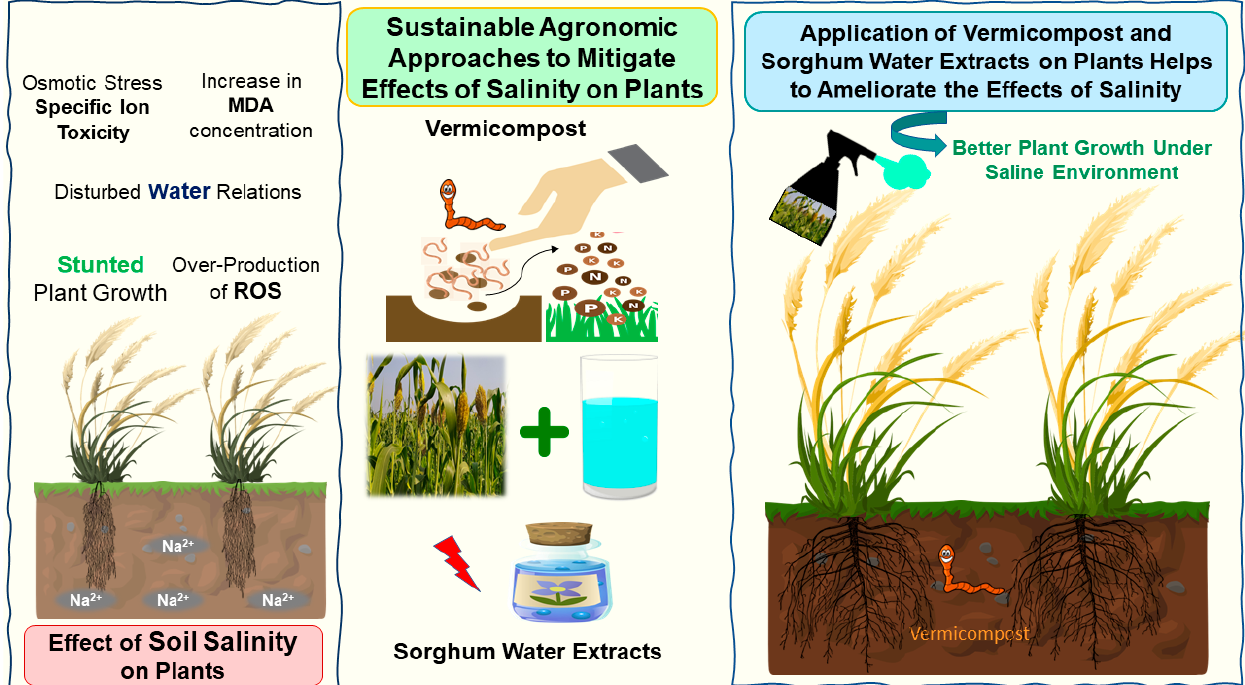
Figure 8. Graphical illustration of the effect of salinity on plants and sustainable agronomic options to mitigate it.